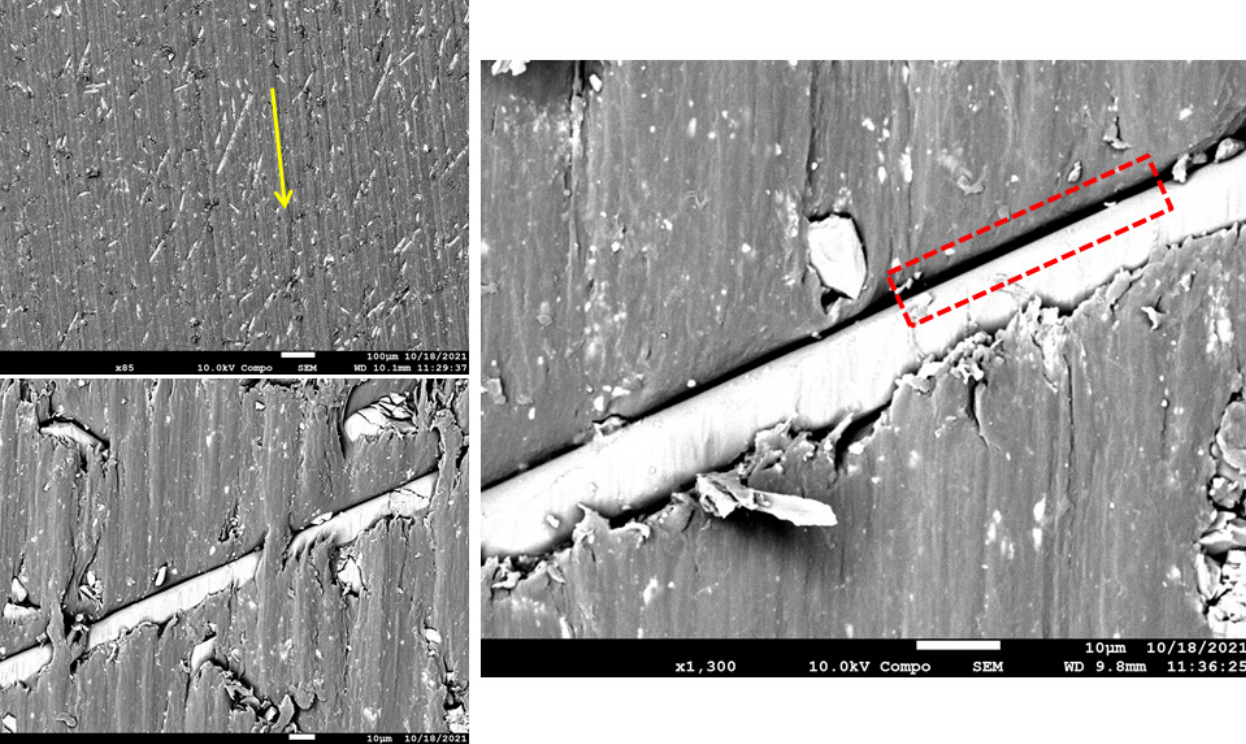
Figure 15. FESEM Micrographs for the worn-out surfaces of PA625GF at different magnifications.